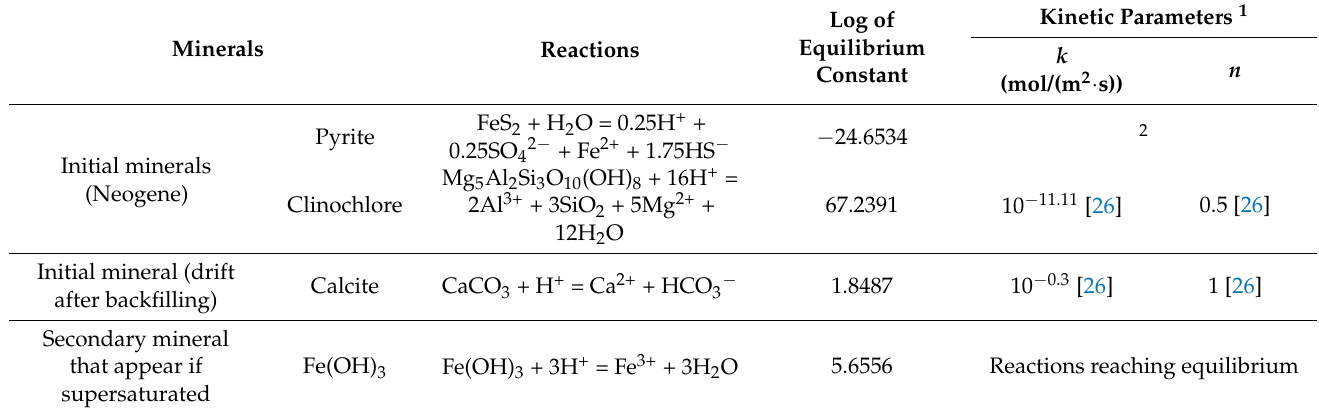
Table 5. Modeled reactions and parameters.